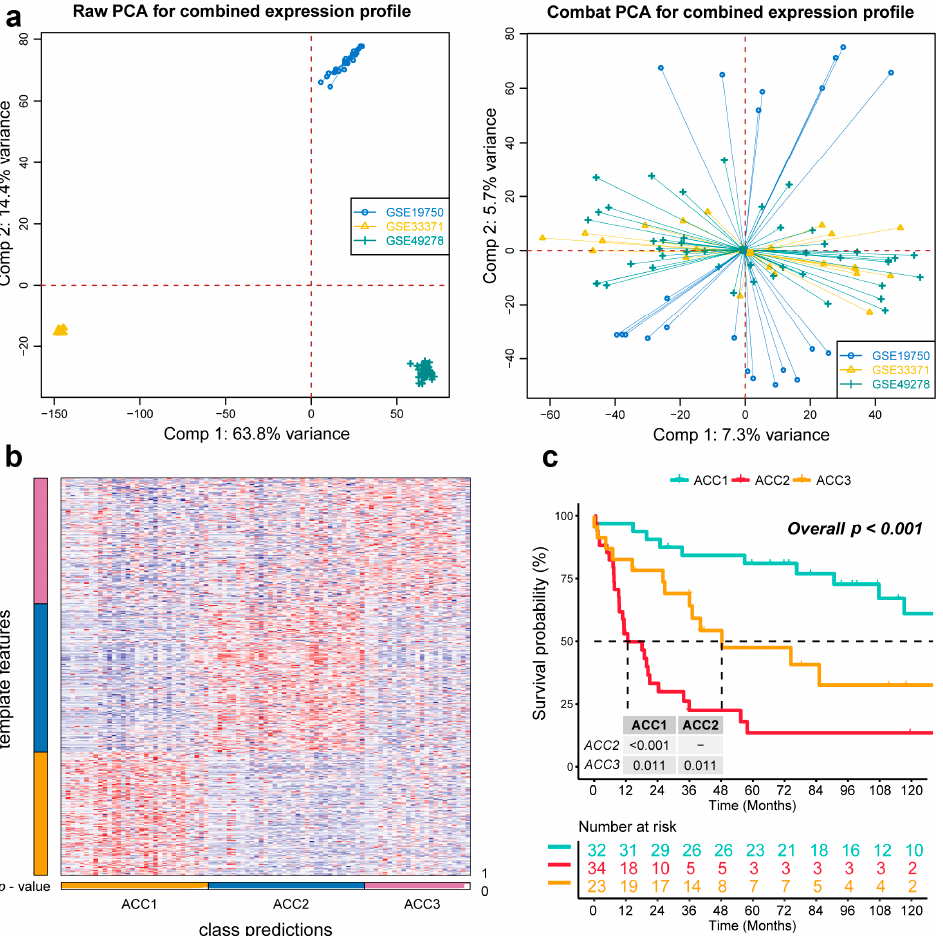
Figure 7. Recognition of the adrenocortical carcinoma multi ‐ omics classification system in the GEO cohort. ( a ) The combat algorithm eliminates the queue batch effect. ( b ) Representing the ACCs in the GEO cohort. ( c ) Differential overall survival outcome in reproduced ACCs of GEO cohorts, log ‐ rank test.